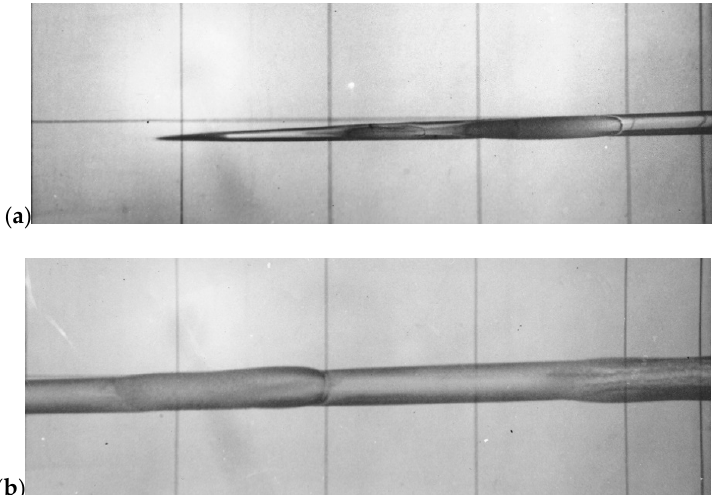
Figure 2. Bouncing regime of supercavitation at a speed of 910 m/s. The body length L = 150 mm, the stern diameter D = 10 mm, and the cavitator diameter D = 1.2 mm; ( a ) the projectile impacting the supercavity side. ( b ) Bouncing marks on the supercavity at a later instant.